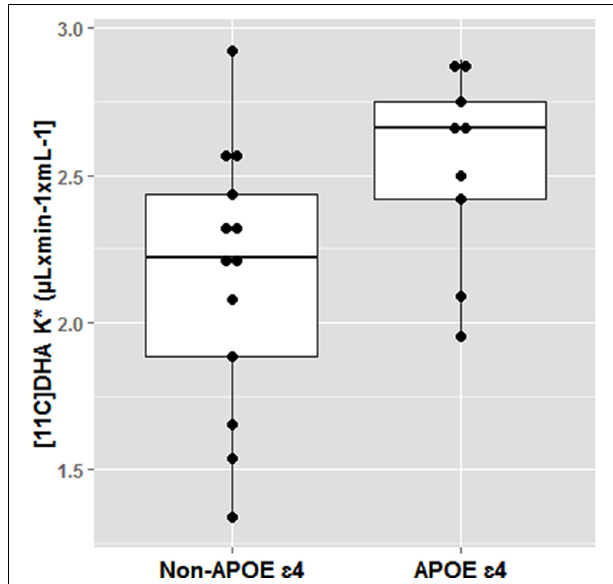
FIGURE 5 | Docosahexaenoic acid (DHA) brain uptake by APOE4 carrier state. Cognitively healthy younger APOE4 carriers had greater brain DHA uptake using an 11 C-DHA PET scan. * p < 0.05. Adapted from Yassine et al.